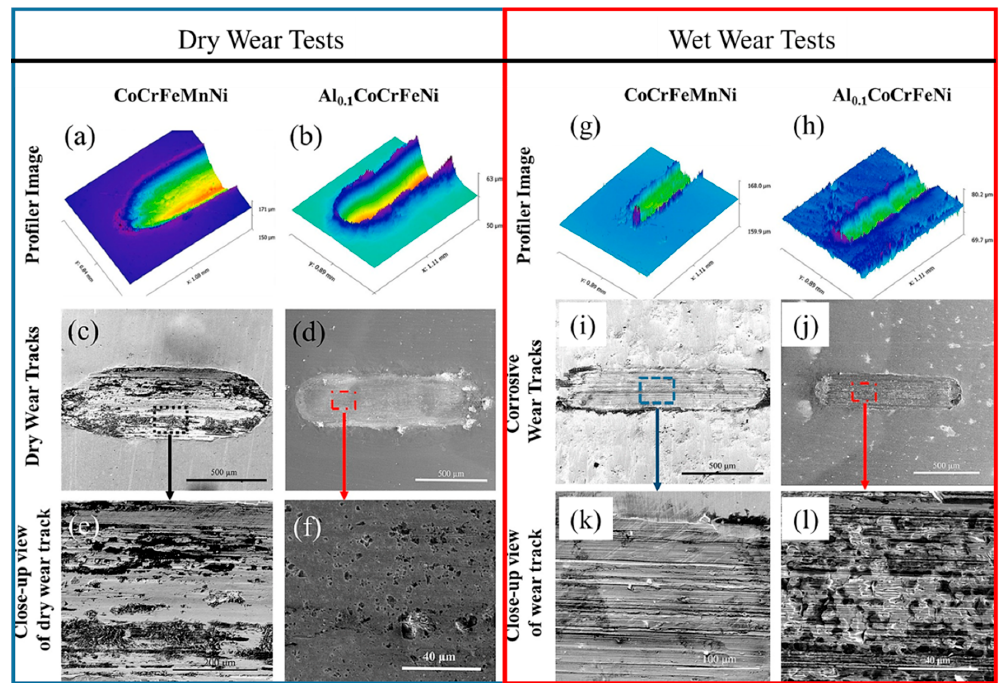
Figure 31. Interferometry images of dry wear track for ( a ) CoCrFeMnNi and ( b ) Al 0.1 CoCrFeNi. Scanning Electron Microscope images of wear track on ( c ) CoCrFeMnNi and ( d ) Al 0.1 CoCrFeNi; Higher magnification images of wear tracks for ( e ) CoCrFeMnNi showing coarse microabrasion/microcutting and ( f ) Al 0.1 CoCrFeNi showing finer microabrasion, deformation and delamination of oxide layer; The corresponding interferometry images of wear tracks generated during marine wear for ( g ) CoCrFeMnNi and ( h ) Al 0.1 CoCrFeNi. Scanning Electron Microscope images of wear track due to corrosive wear on ( i ) CoCrFeMnNi and ( j ) Al 0.1 CoCrFeNi; Higher magnification images of wear tracks for ( k ) CoCrFeMnNi showing fine microabrasion/microcutting and shallow deformation and ( l ) Al 0.1 CoCrFeNi showing corrosive wear in terms of break-down of surface passive layers [31] (reprinted with permission from Elsevier).